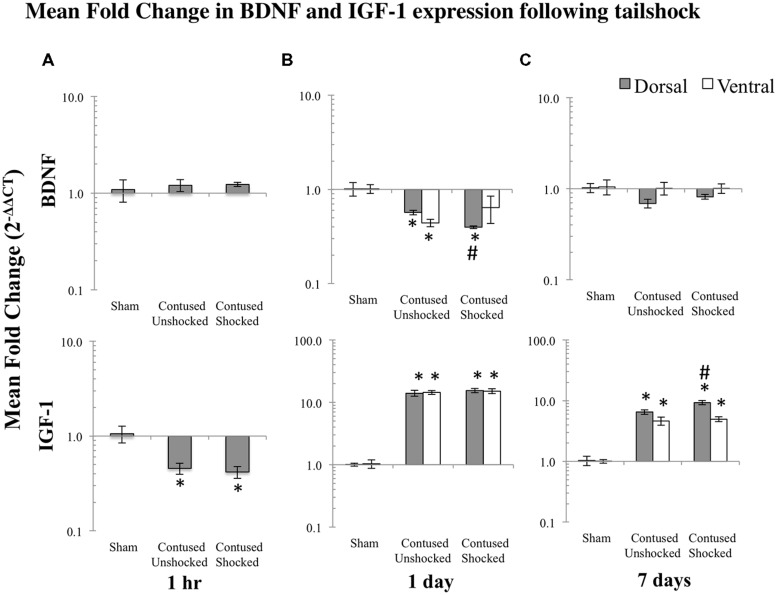
Bar graphs depict qRT-PCR analysis of BDNF and IGF-1 mRNA expression at the lesion site following shock treatment in contused animals, compared to sham lesioned controls and non-shocked (unshock), lesioned animals at 1 h (A), 1 day (B), or 7 days (C) following tailshock treatment. The x-axis denotes treatment condition, and the y-axis denotes the log of mean fold expression change of mRNA. Data were normalized relative to GAPDH mRNA and expressed as the mean of fold changes of individual samples within a treatment group relative to the mean of the treatment group (+EM). As indicated in the text, there were significant main effects of time and spinal cord region (dorsal versus ventral) on mRNA expression. Within each time group, asterisks indicate significance (LSD) compared with time-group specific sham controls and hash tags indicate significance (LSD) compared with contused unshocked controls; p values are as indicated in the text.